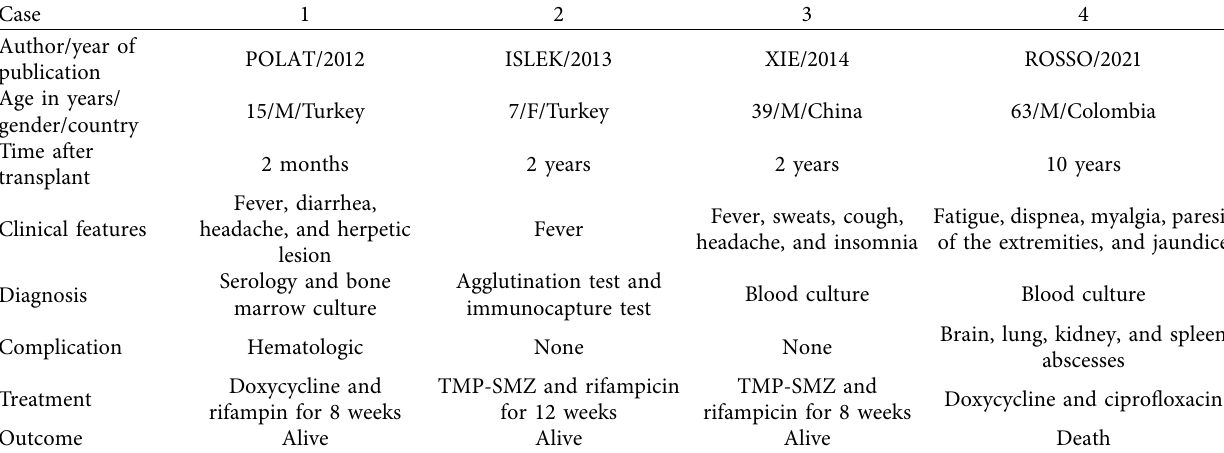
Table 1: Previous reported cases of brucellosis in liver transplant